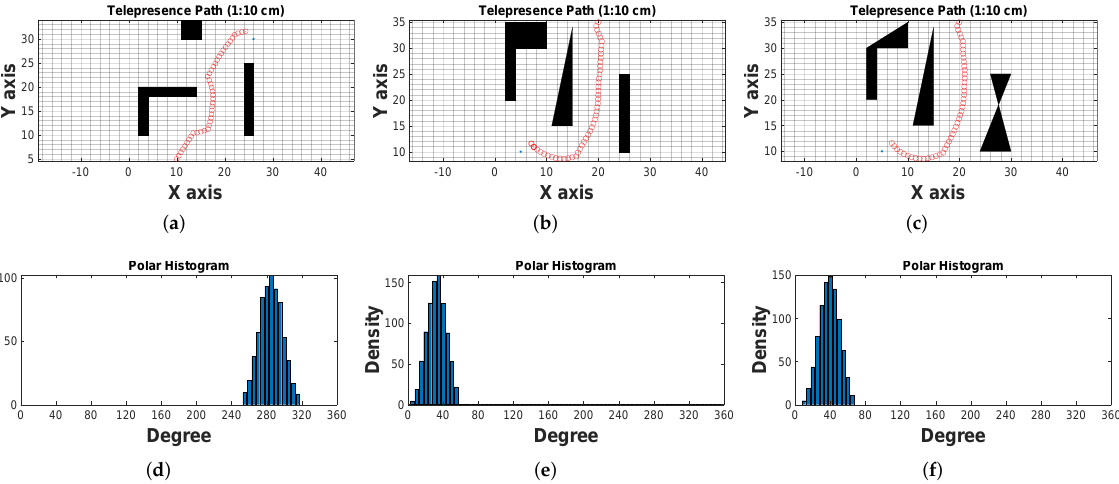
Figure 9. ( a ) Case 1: square, L and I shape hurdles; ( b ) Case 2: polygon, I and triangular hurdles; ( c ) Case 3: square, L and I shape hurdles; ( d ) Case 1: Histogram of tricon sensors; ( e ) Case 2: Histogram of tricon sensors; ( f ) Case 3: Histogram of tricon